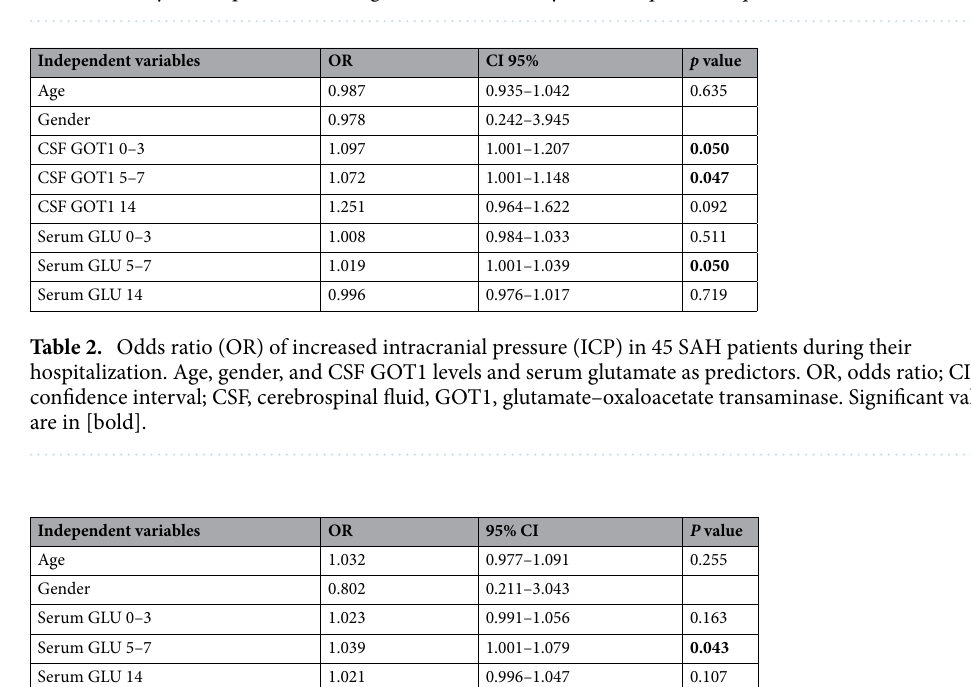
Figure 5. Correlations between CSF GOT1 levels and high ICP, brain ischemia, and clinical outcome. CSF GOT1 levels on days 0–3, 5–7, and 14 post-SAH, in association with the presence of increased intracranial pressure (ICP) ( A ), and at days 5–7 post-SAH with the presence of brain ischemia (hypodense lesion on a brain CT) ( B ). Correlation between CSF GOT1 levels at days 0–3, 5–7, and 14 post-SAH and outcome defined as “good” (GOS IV–V) versus “poor” (GOS I–III) 3 months post-SAH ( C ), hospital length of stay (LOS) ( D ), and the presence of neurological deficits at discharge ( E ). Data are expressed as the median and interquartile range. Statistical analysis was performed using the Mann–Whitney test ( B ), * p < 0.05, ** p < 0.01.